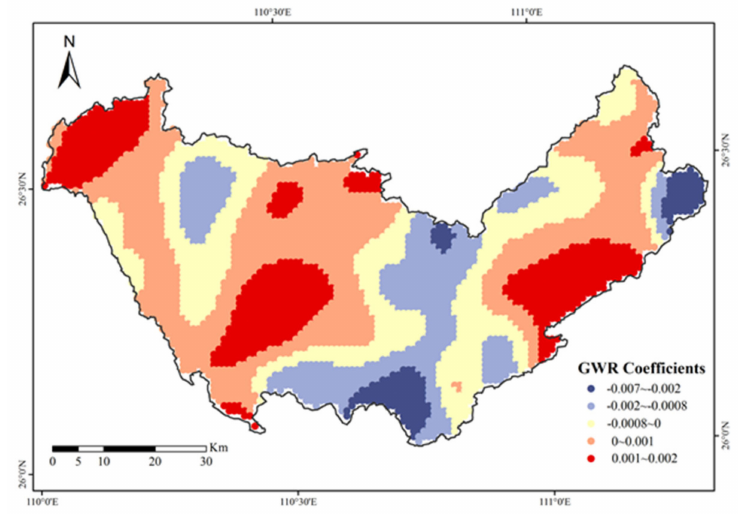
Figure 7. Spatial distribution of regression coe ffi cients from the GWR models for NDVI and e ff ective mesh